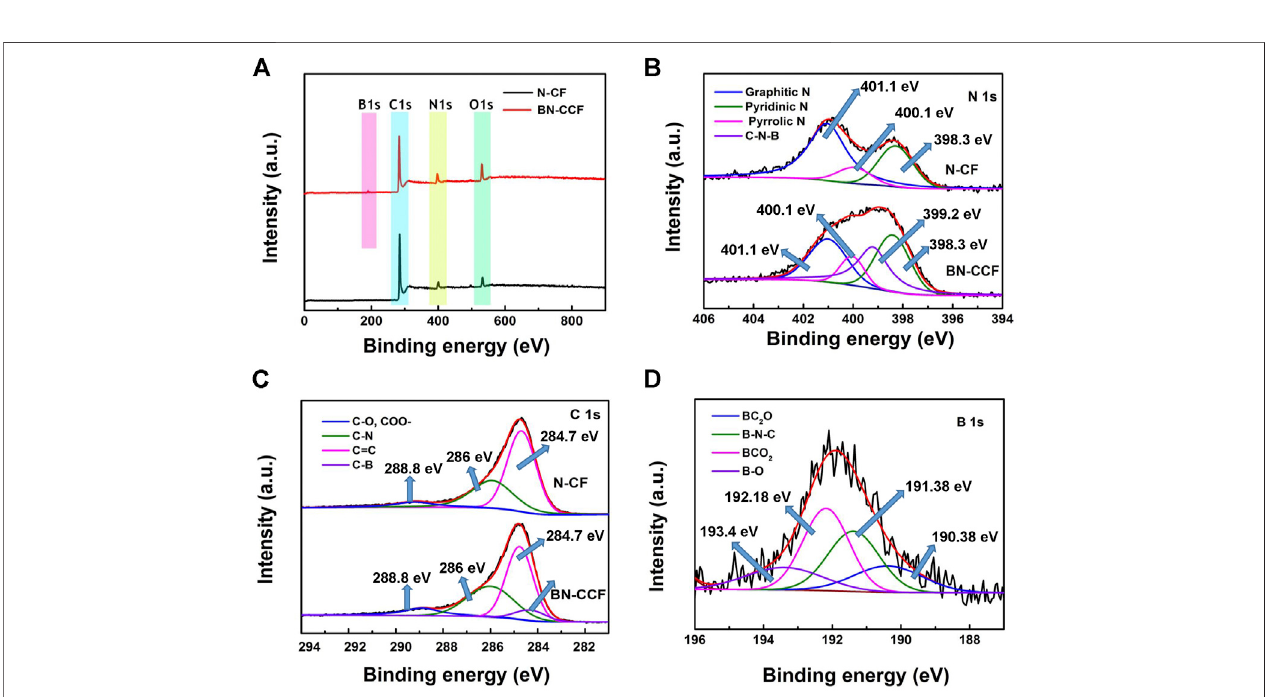
FIGURE 4 | (A) XPS survey spectra of N-CF and BN-CCF (B) N 1s and (C) C 1s XPS spectra of N-CF and BN-CCF (D) B 1s XPS spectrum of